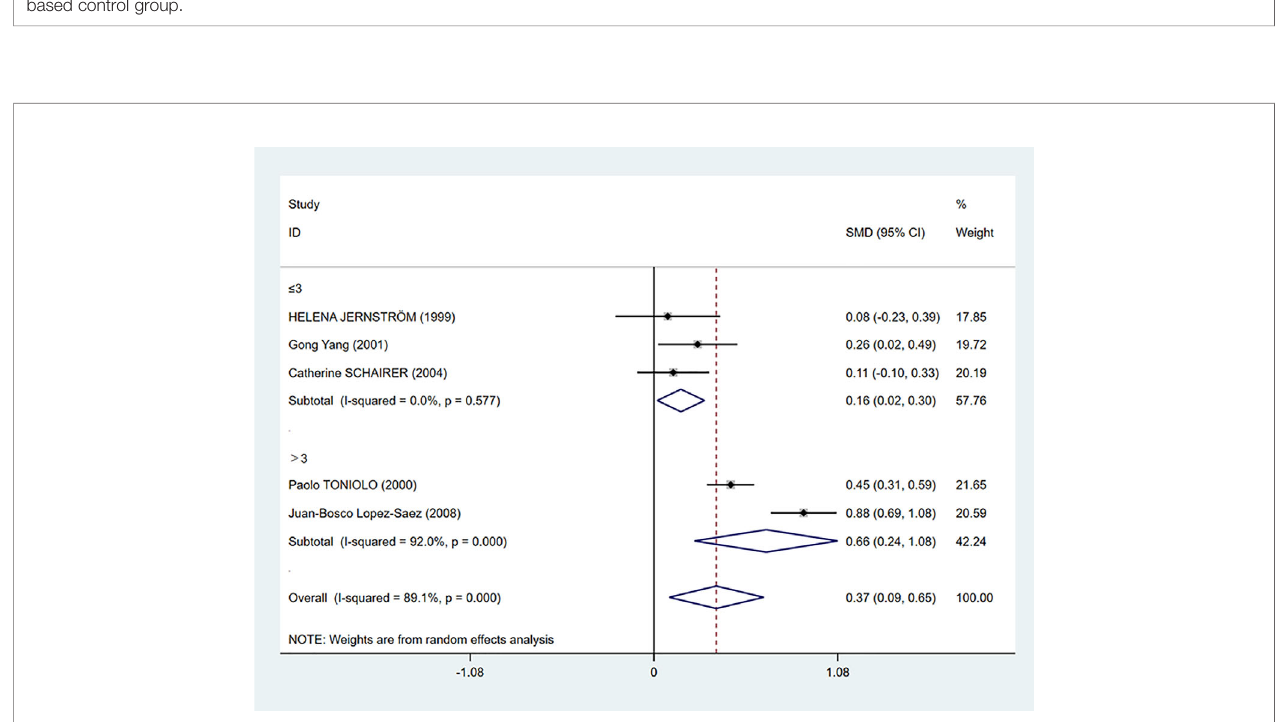
FIGURE 4 | Subgroup analysis of the association between C-peptide levels and breast cancer in C-peptide ≤ 3 or >3 ng/ml. The size of the square box is proportional to the weight that each study contributes in the meta-analysis. The overall estimate and CI are marked by a diamond. Summary estimates were analyzed using a random-effects model. C-peptide levels are positively associated with breast cancer risk in both ≤ 3 and >3 ng/ml